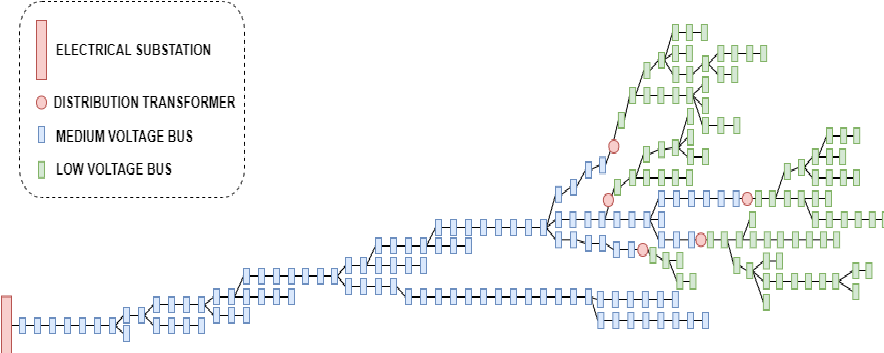
Figure 5. Network Topology of the PDS used to carry out the